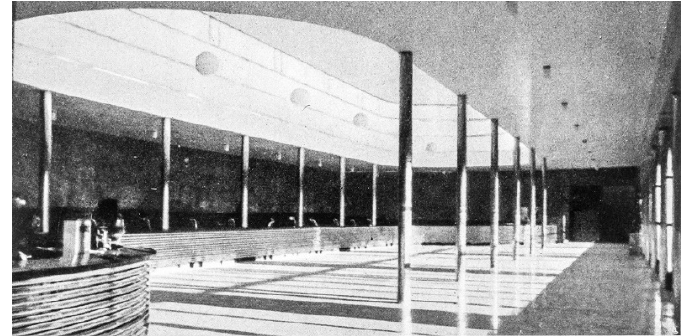
Figure 11. Post Office building by Adalberto Libera and Mario De Renzi. Rome (1933–1935). The hall. Photo from (Pica 1936, p. 301).